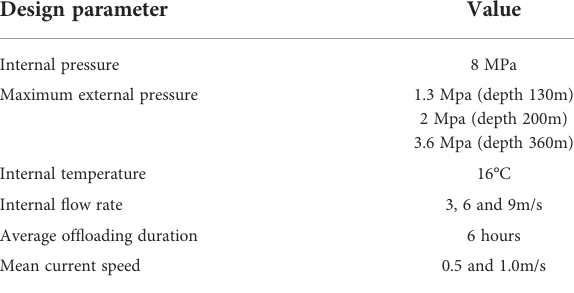
TABLE 2 The load conditions for fl owline during of fl oading